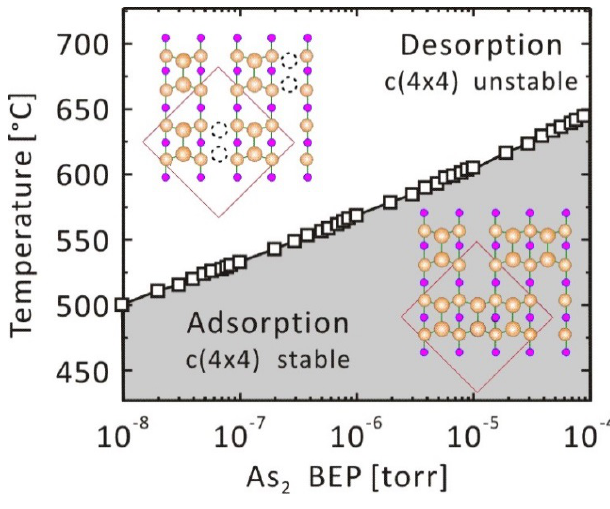
Figure 5. Pressure-temperature phase diagram for the GaAs(001)-c(4 ×